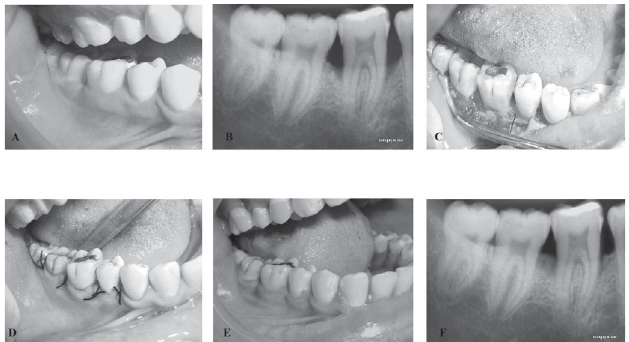
Fig. 3. Surgical procedure in Group II (BG alone). A. Preoperative clinical view; B. Preoperative radiograph with intrabony defects on mesial and distal sides of tooth 46; C. Intraoperative view depicting graft placement after full-thickness flap elevation; D. Postoperative view (after flap closure); E. Postoperative view (6 months); F.